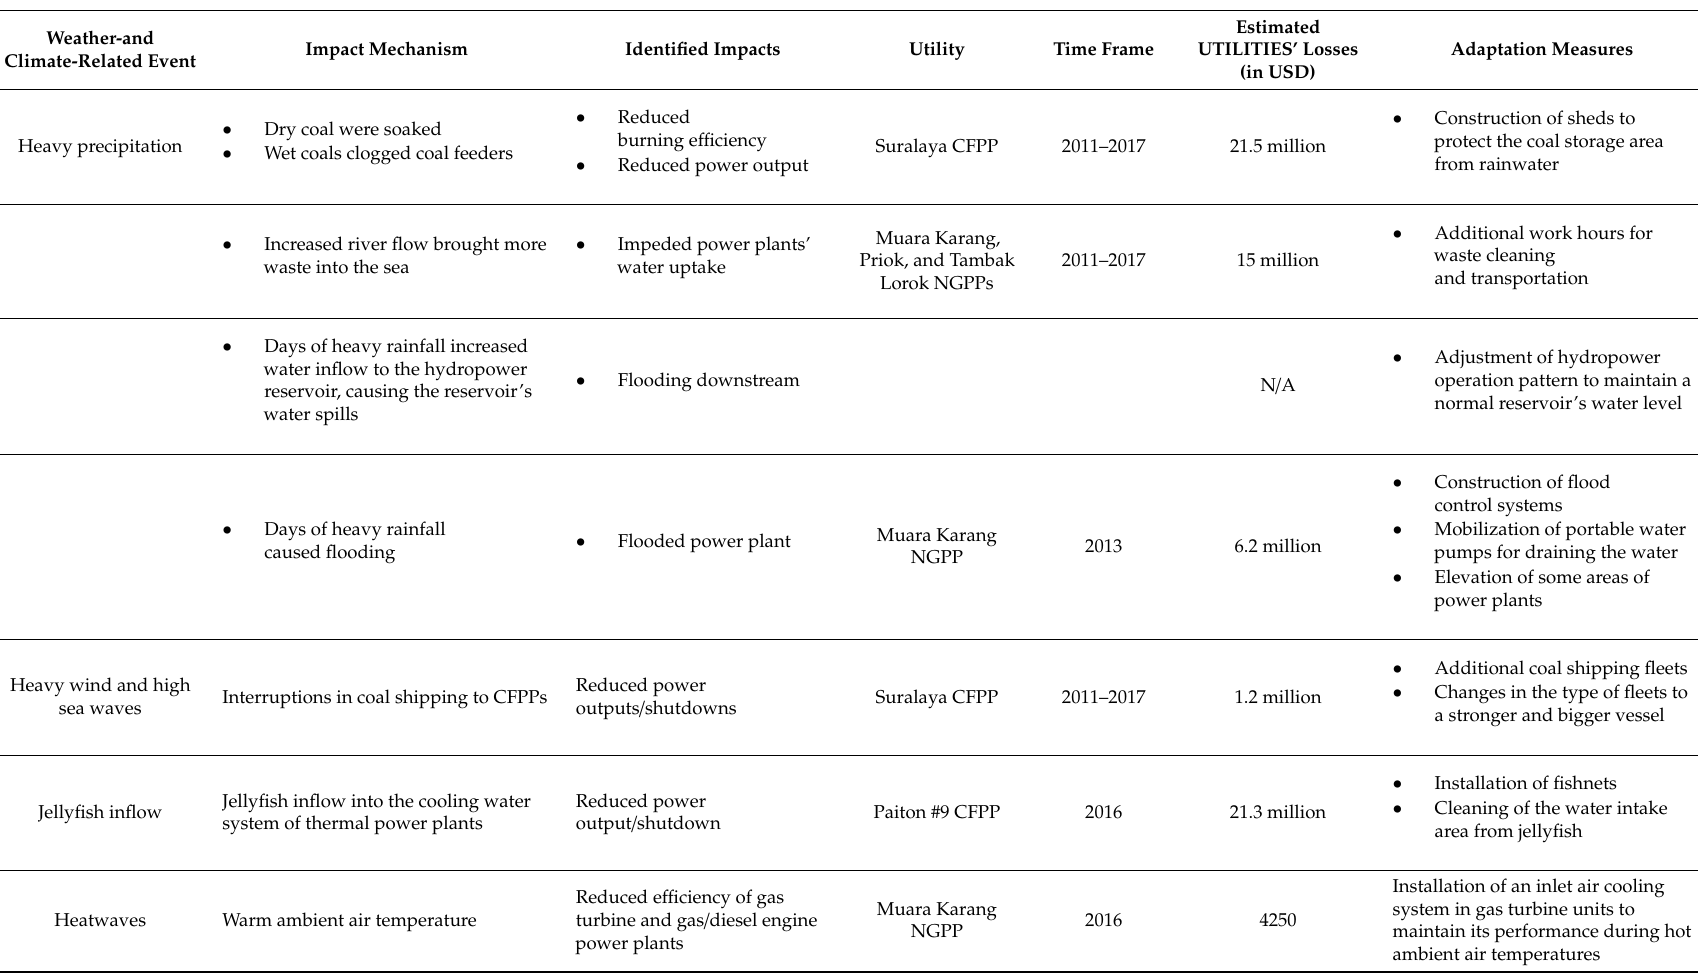
Table 4. Impacts of severe weather events on power generation and utilities’ autonomous adaptation measures. Source: own